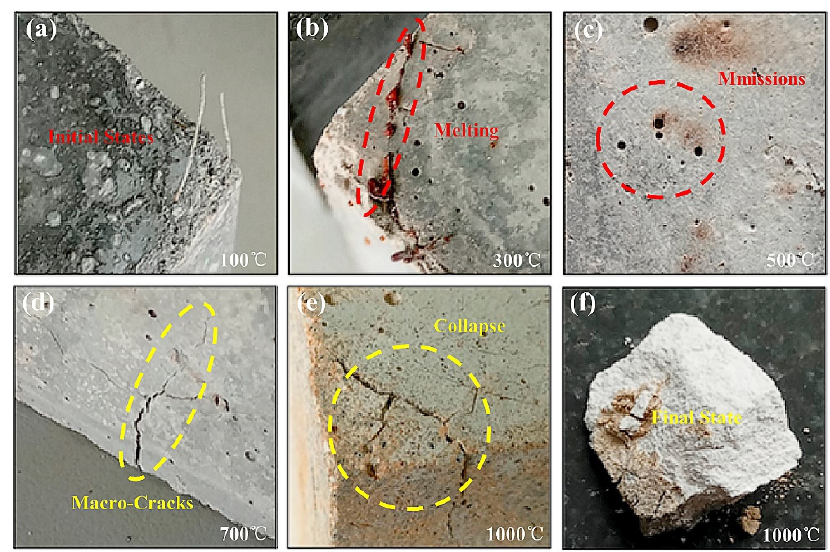
Figure 16. Details of the macrostructure after exposure to high temperatures at ( a ) 100 °C, ( b ) 300 °C, ( c ) 500 °C, ( d ) 700 °C, ( e ) and ( f ) 1000 °C [102].